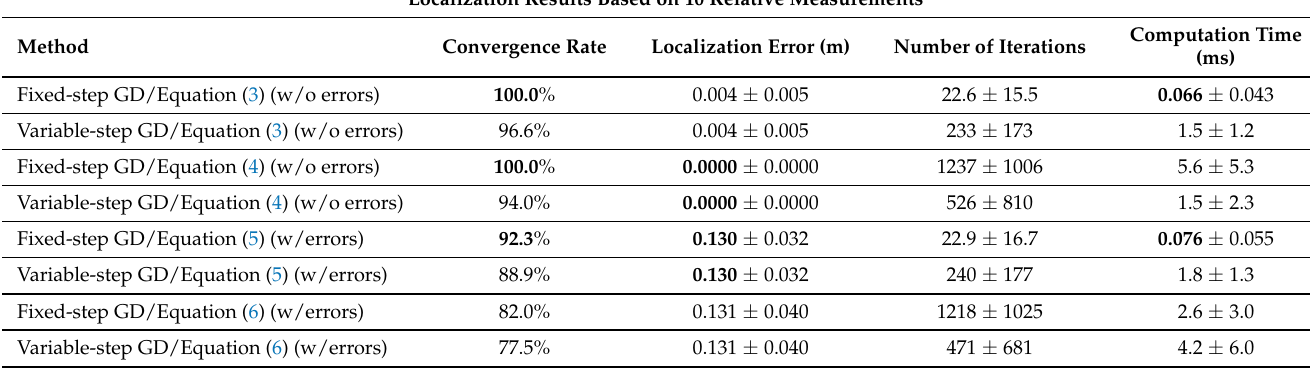
Table 8. Comparative localization results using the different formulations of the estimation problem based on 10 relative measurements, with and without taking into account uncertainty